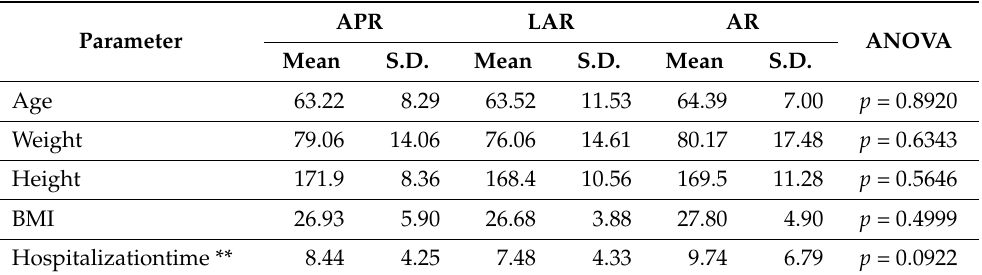
Table 1. Quantitative clinical data in the studied groups of patients (abdominoperineal resection, anterior resection and laparoscopic anterior resection) and the relationships between those groups.